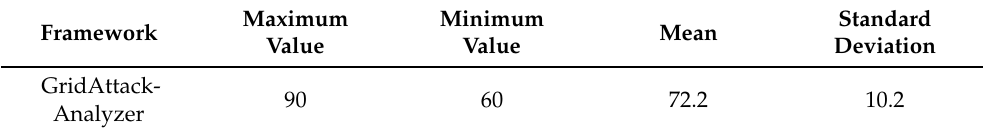
Table 7. SUS Results of